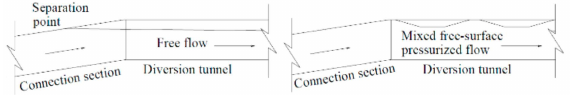
Figure 25. Schematic diagram of the complex flow patterns in an SCTT. Reproduced with permission from [44], ASME, 2013.